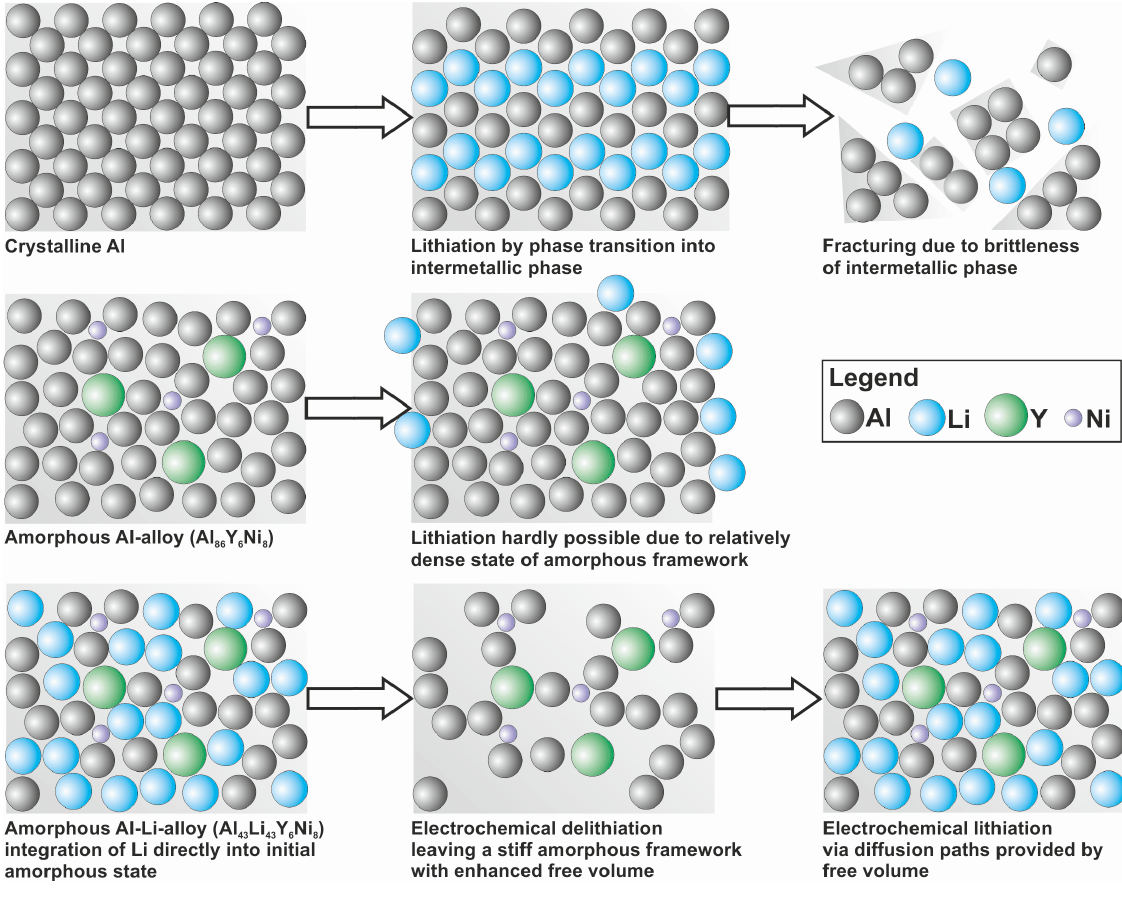
Figure 1. Schematic illustration of the lithiation processes within crystalline Al ( upper row ), the conventional, amorphous compound Al amorphous alloy Al